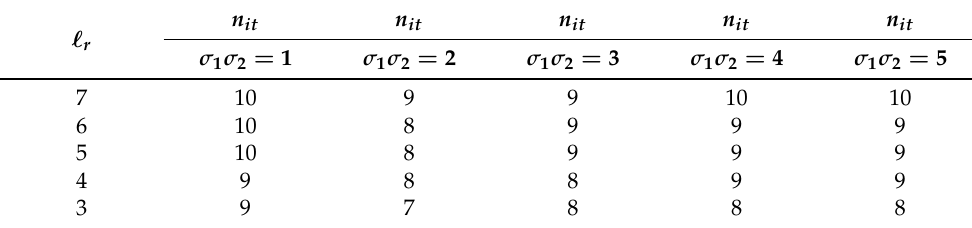
Table 6. Number of PCG iterations n it with preconditioner C BURA σ 1 σ 2 : (cid:96) r levels of uniform mesh refinements and stopping criteria (cid:101) = 10 − 6 .